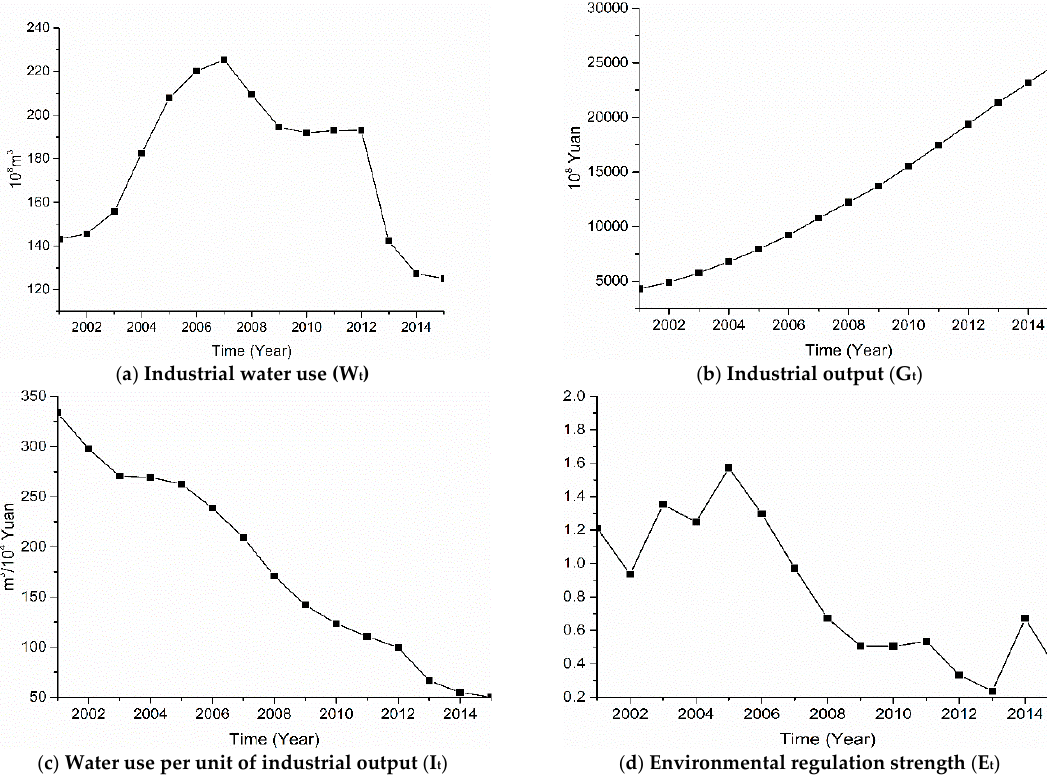
Figure 2. Change trends of variables from 2001 to 2015.